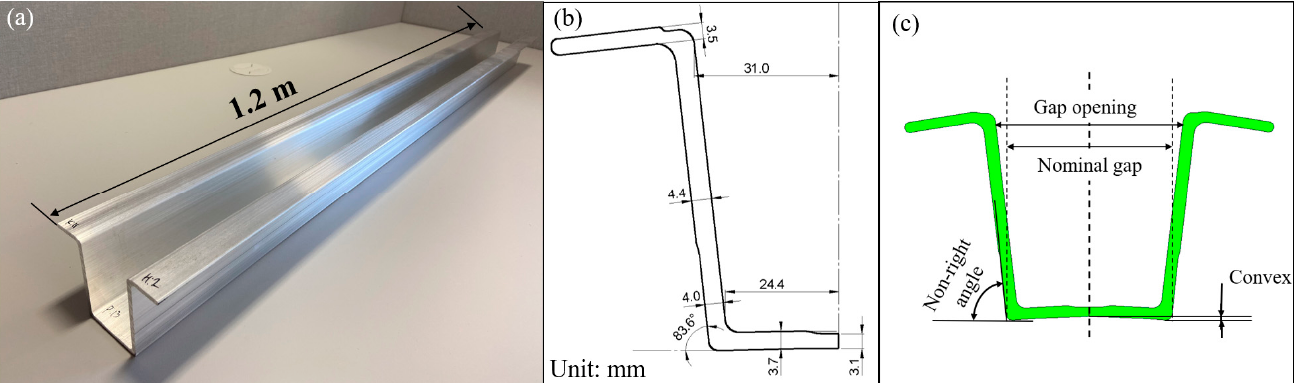
Figure 1. Description of ( a ) as-received sample; ( b ) dimensions on half of the transverse cross section; and ( c ) dimensional defects including gap opening, non-right angle, and unexpected convex.